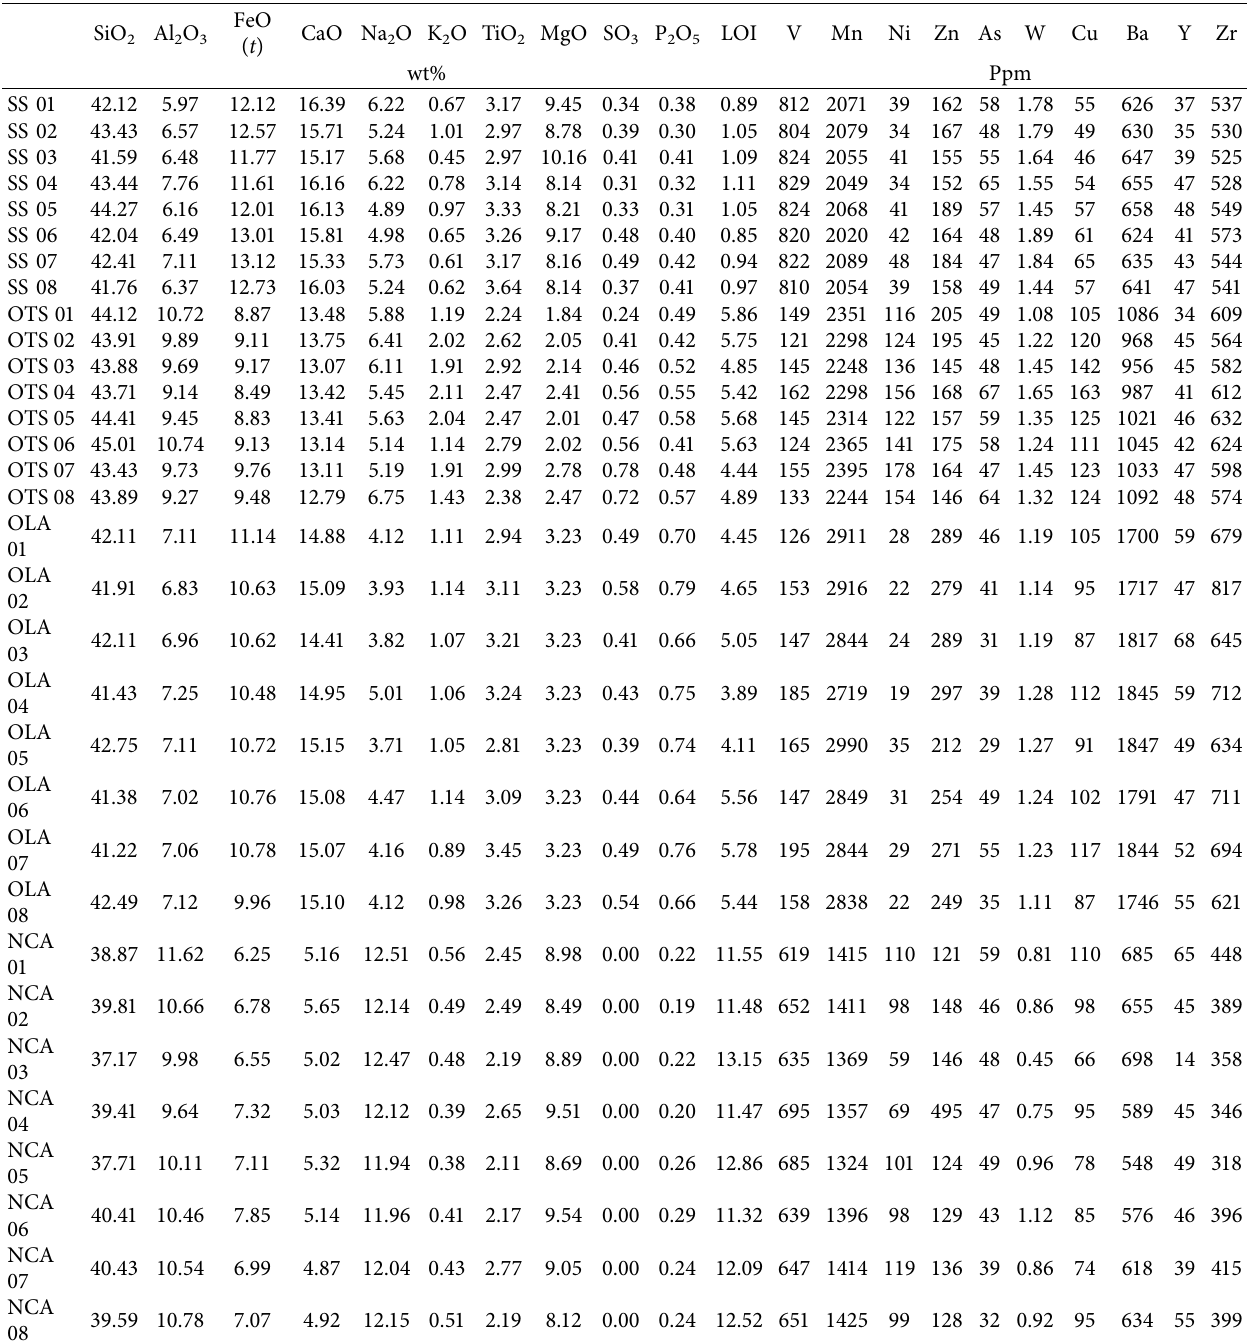
Table 2: Major and minor oxides (wt%) and trace elements (ppm) of SS, OTS, OLA, and NCA samples (EDXRF data are not normalized). SiO 2 Al 2 O